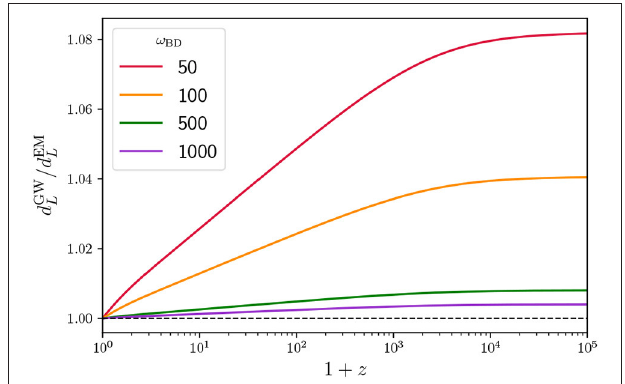
FIGURE 12 | Ratio between the GW and the EM luminosity distances in Brans-Dicke for different values of ω BD , cf. Equation